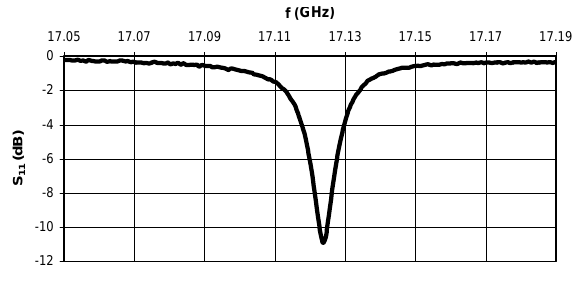
FIG. 2. Cold test of the new RF gun.